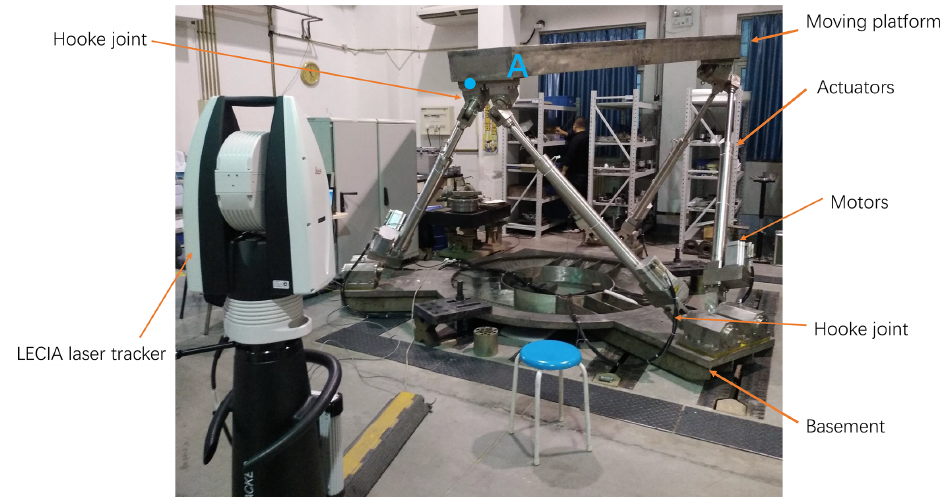
Figure 10. Experimental setup of electrically driven Stewart platform and laser tracker.